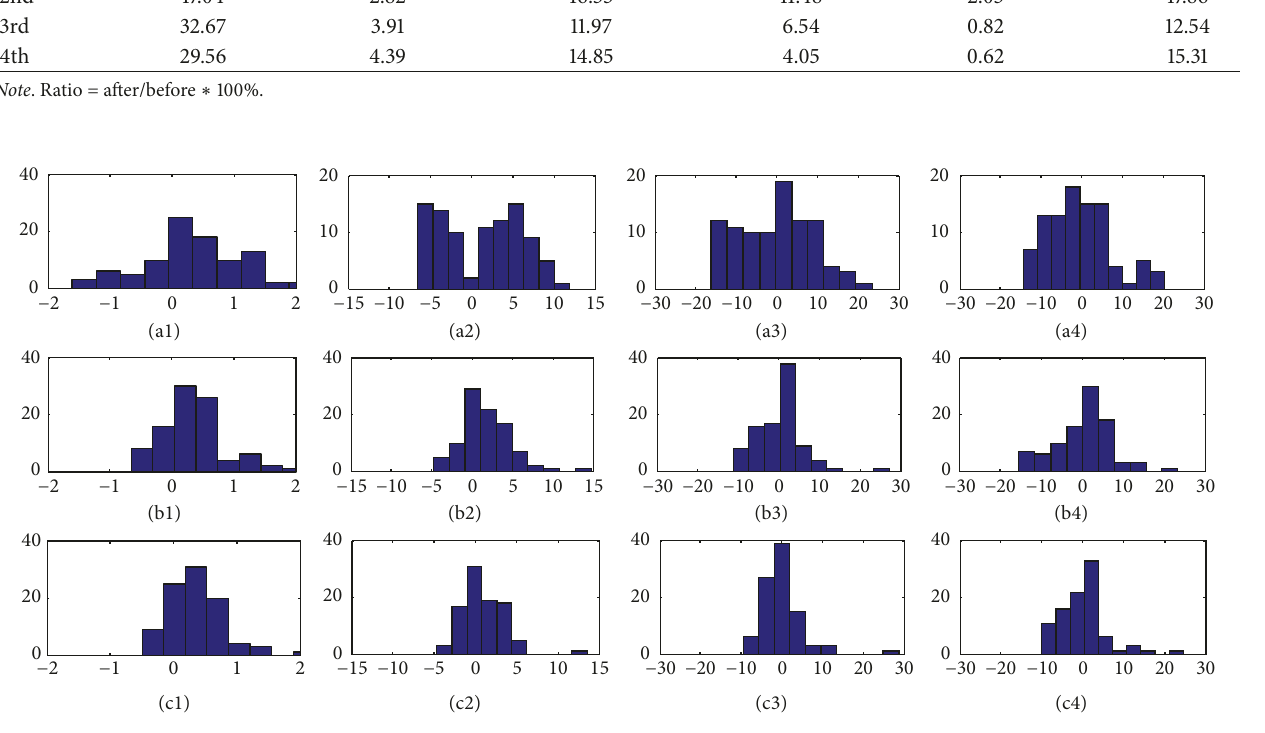
Figure 9: Histograms of PEs generated by three regression models on test set (horizontal axis represents PEs, and vertical axis represents sample number). (a1) MLR for 1st mode; (a2) MLR for 2nd mode; (a3) MLR for 3rd mode; (a4) MLR for 4th mode; (b1) BPNN for 1st